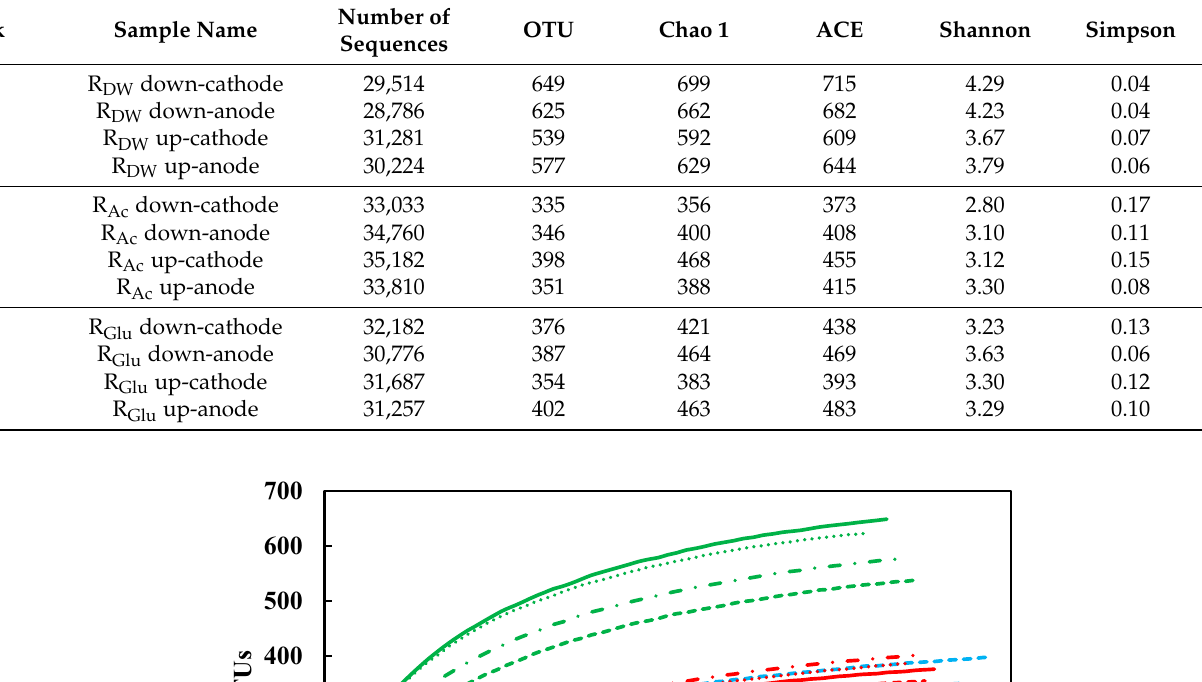
Table 1. Nomenclature and alpha diversity of 12 microbial communities.